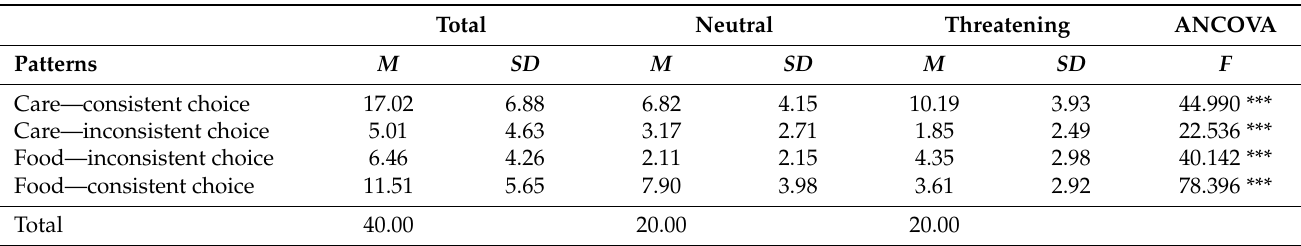
Table 3. Means and SDs of the total four consistency-choice patterns under neutral and threaten- ing conditions.